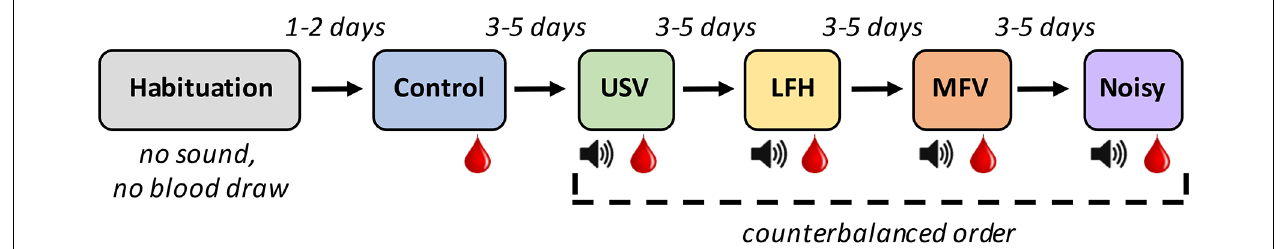
FIGURE 2 | Experimental design for playback experiment: Six 30-min trials of different types were experienced by each animal. The Red drop represents trials after which blood was drawn. The Speaker symbol represents trials in which the animal was exposed to exemplars of the indicated vocalization category.